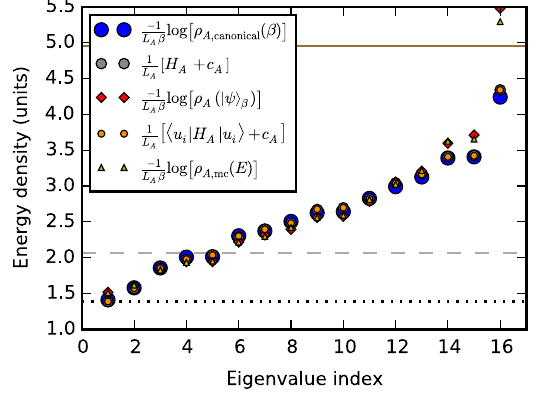
FIG. 8. Comparison of the five quantities defined in the inset 4 subsystem at L ¼ 21 and β ¼ 0 . 3 . Each quantity for an L A ¼ has been normalized so that the y axis has units of energy density. The large blue circle markers show the spectrum of the canonical reduced density matrix, while the red diamond markers corre- ψ i spond to the eigenvalues of a reduced density matrix ρ β Þ for A ðj a single eigenstate at temperature β − 1 . The yellow triangle markers show the spectrum of the microcanonical reduced density matrix that consists of an equal-weighted mixture of the 50 eigenstates nearest in energy to the one under consid- eration. The grey markers show the eigenvalues of H with a shift A ≡ ð 1 = β Þ log Z 1 = β Þ log tr c e − β H A Þ so that it can be di- A A ¼ ð A ð ψ i rectly compared with − ð 1 = β Þ log ½ ρ β Þ(cid:2) in accordance with A ðj c is independent Eq. (2b) (note, also, that the combination H A þ A of the shift of the spectrum of H by an arbitrary uniform A constant). Finally, the orange markers represent the expectation value of H , again with a shift c , with respect to the Schmidt A A ψ i eigenvector j u of ρ β Þ . In each case, the eigenvalues/ i i A ðj eigenvectors are ordered from smallest to largest energy density. The horizontal lines plot the energy density e (dashed grey line) and the critical energy density e (cid:3) ¼ eL=L (solid brown line) of A the original eigenstate j ψ i β , with respect to the ground state c energy density of H (dotted black A þ A If ETH holds for all operators in subsystem A, then the results of Ref. [16] imply that the trace norm distance should go tozero as 1 =L . The suggestion that the trace norm distance between the pure state and thermal reduced density matrices with fixed subsystem size would tend to zero was also made in Refs. [49,69]. We restrict ourselves to states in a β range given by 0 . 28 < β < 0 . 32 . In the left panel of Fig. 10, we plot the trace norm distance of every eigenstate in this β range at L ¼ 5 for a few select system sizes. For each system size, A the distribution of the trace norm distance is nearly constant throughout the given β range. The right panel then takes these data for each pair of L and L and plots the mean and A standard deviation of the trace norm distance against 1 =L .